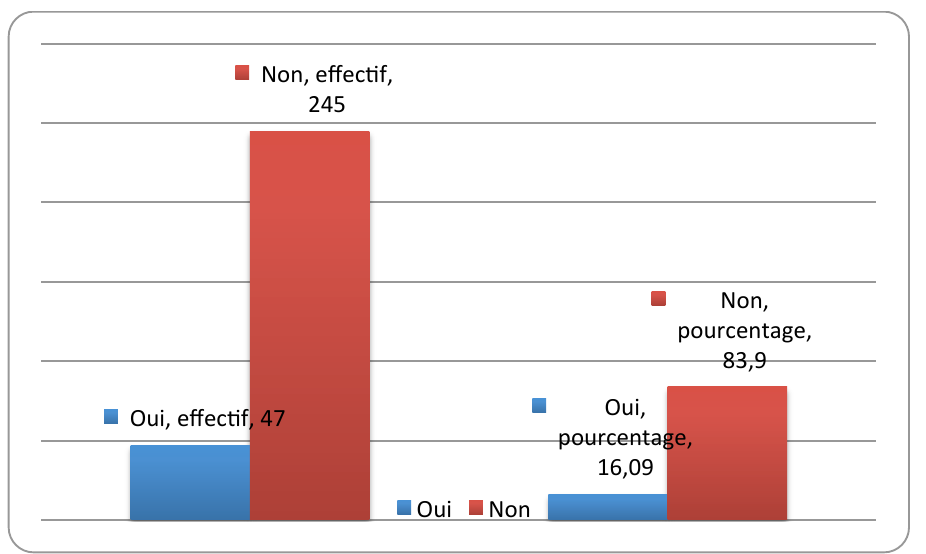
Figure 8. Le confort des maisons